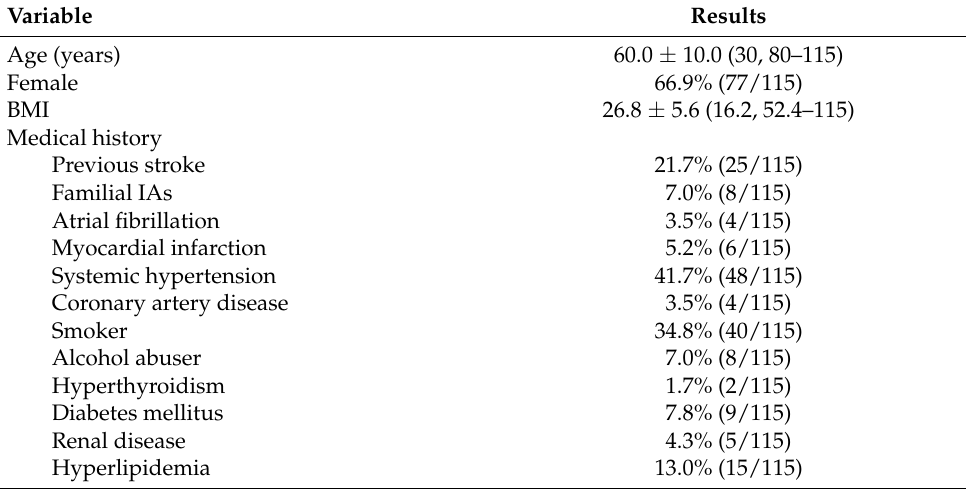
Table 1. Baseline demographics and medical history (ITT